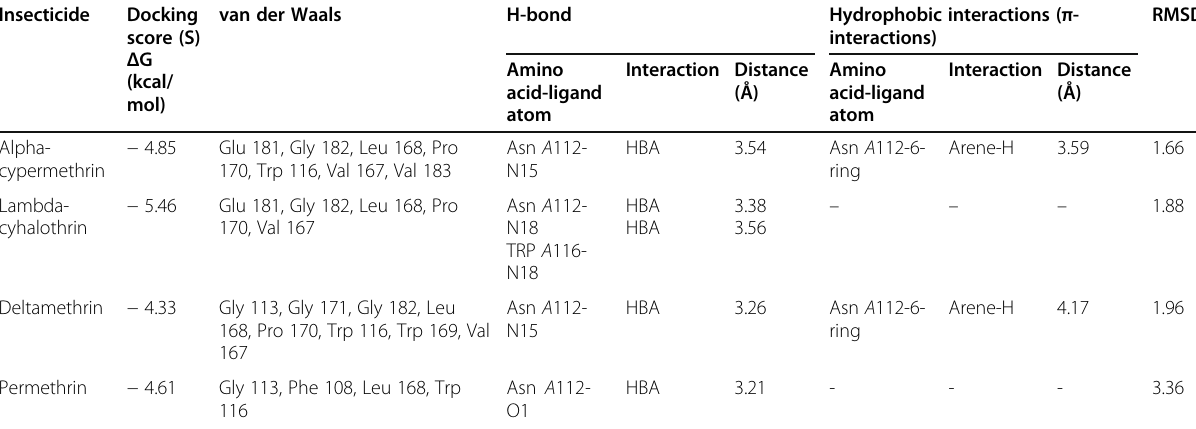
Table 4 Molecular docking, binding scores and binding interactions of tested pyrethroids within the active sites of ATPase (PDB